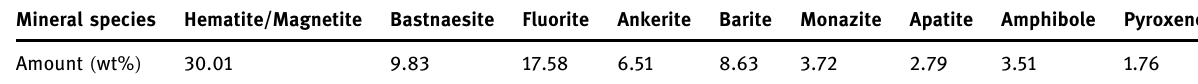
Table 3: Content of major mineral species in Bayan Obo mine tailings Mineral species